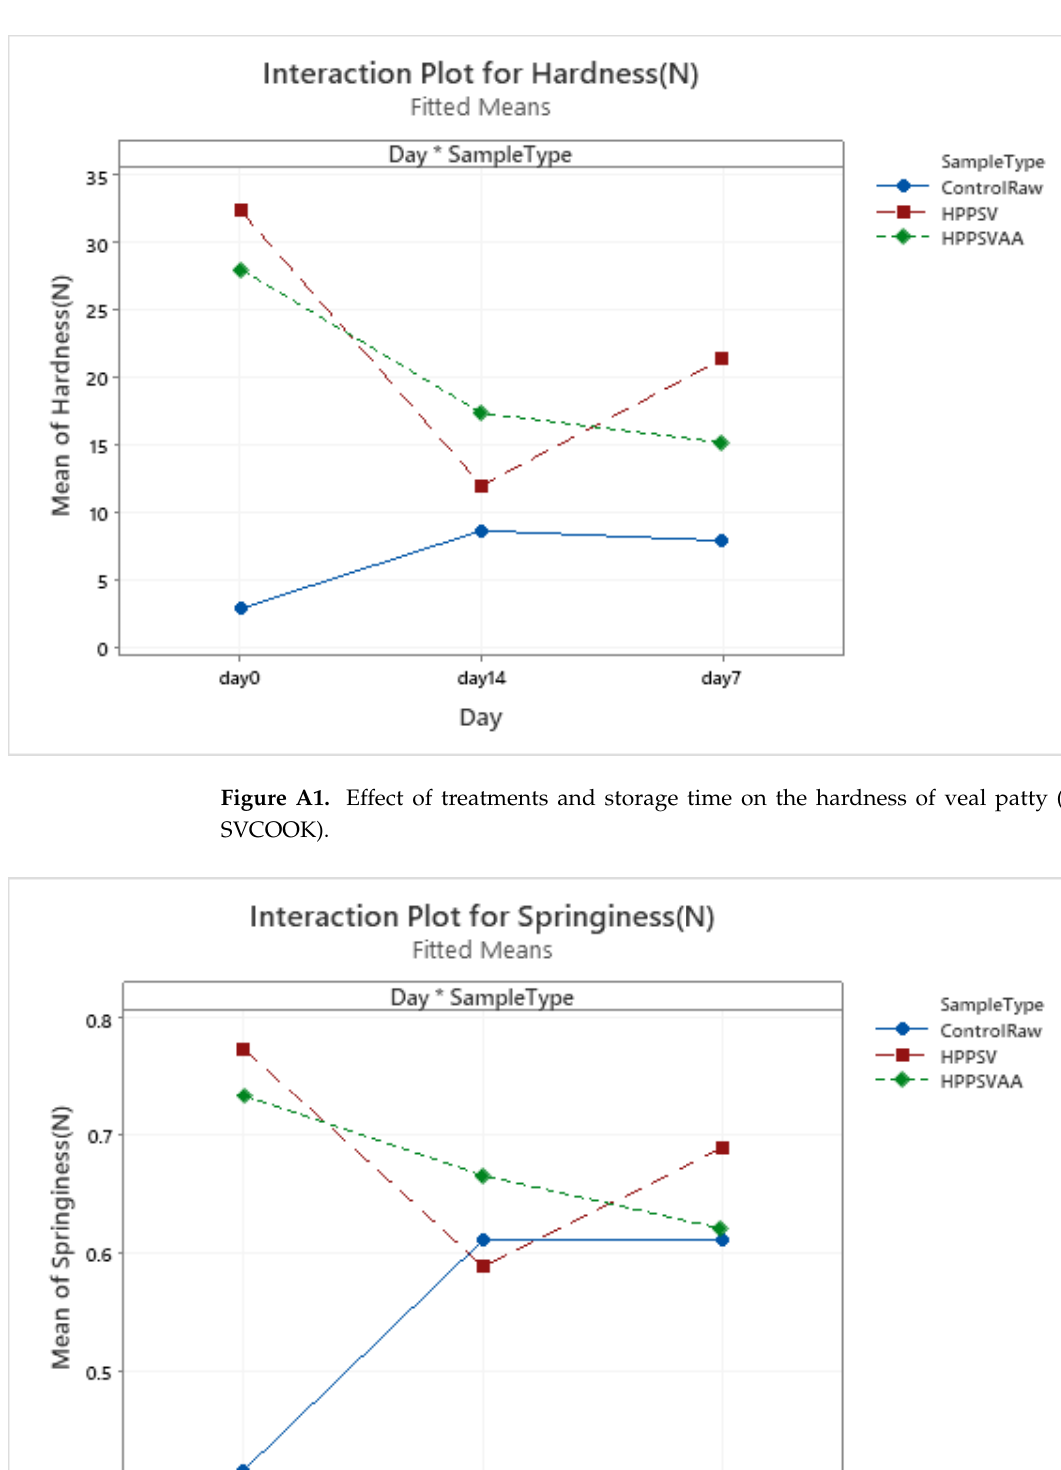
Figure A3. Effect of treatments and storage time on the cohesiveness of veal patty (HPPSV: HPP- SVCOOK).